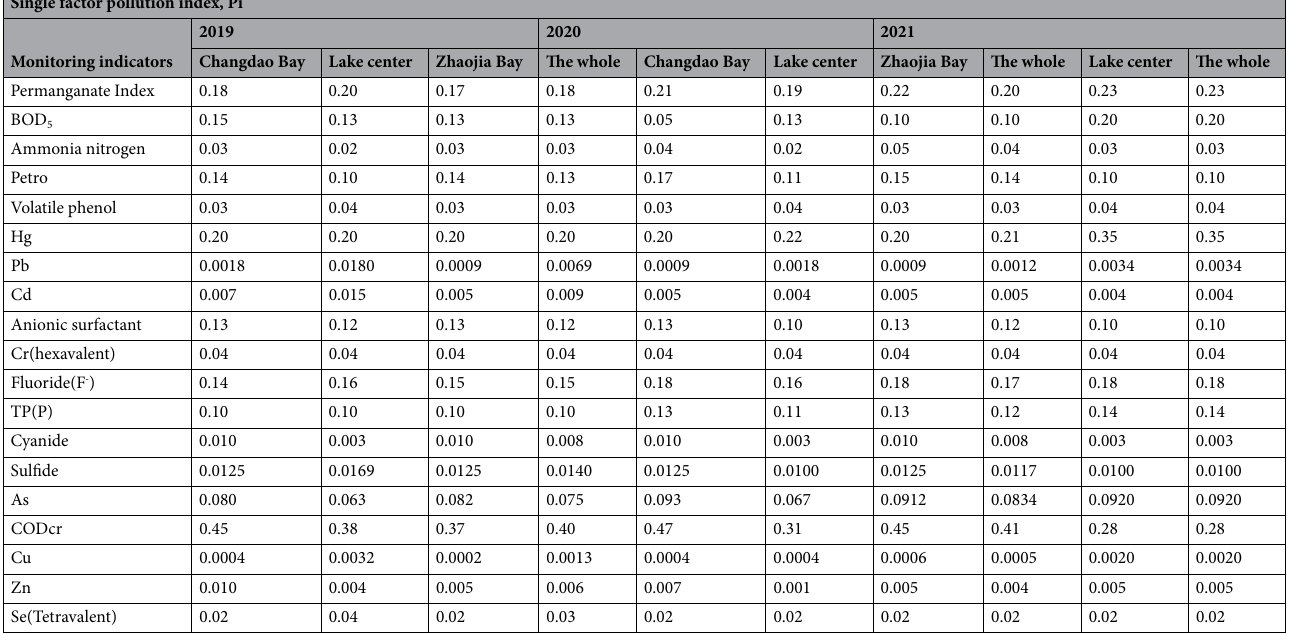
Table 6. Results of water quality assessment by single factor pollution index